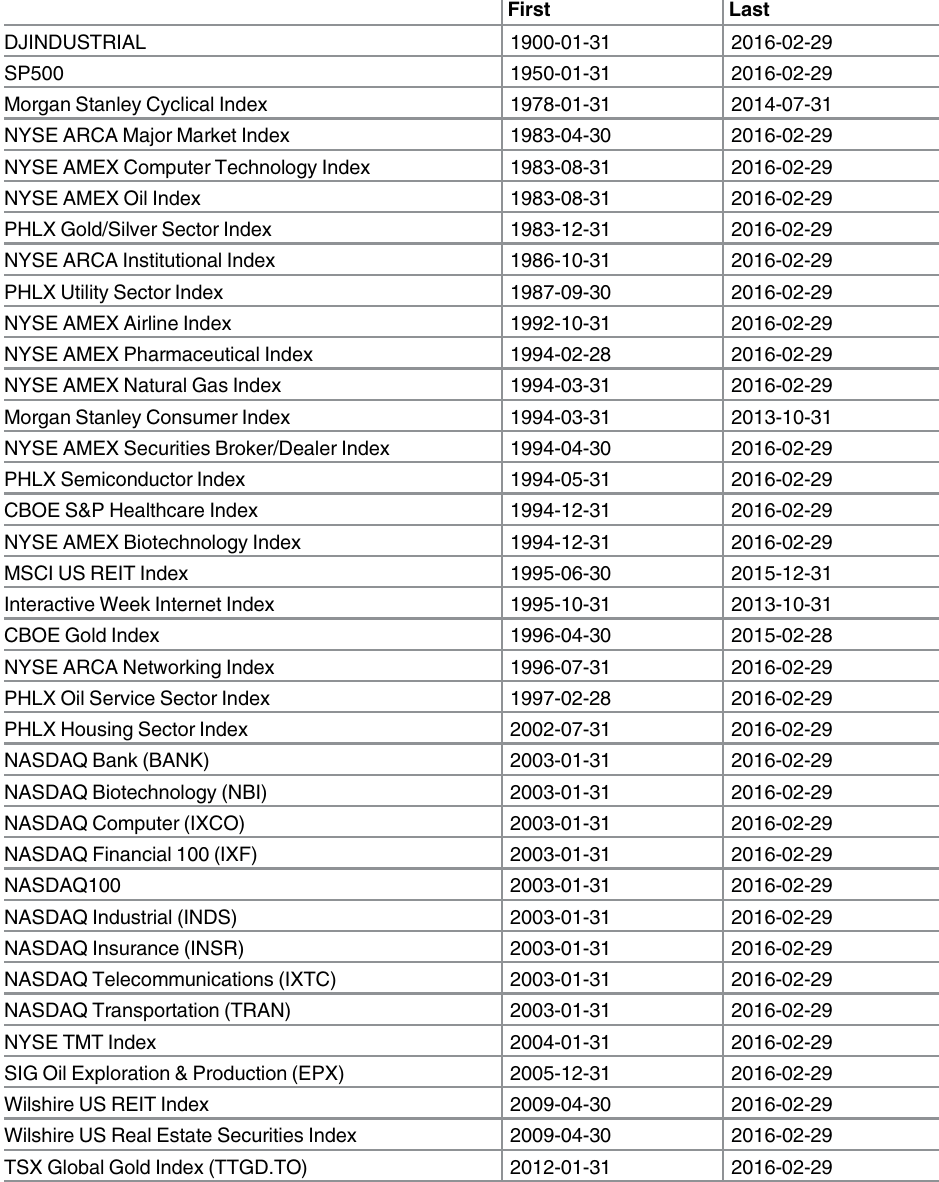
Table 1. List of all US indices used to calculate the efficient frontier and their available time-frames. All Data was downloaded by the QUANDL interface [44]. (See S1 Table) First